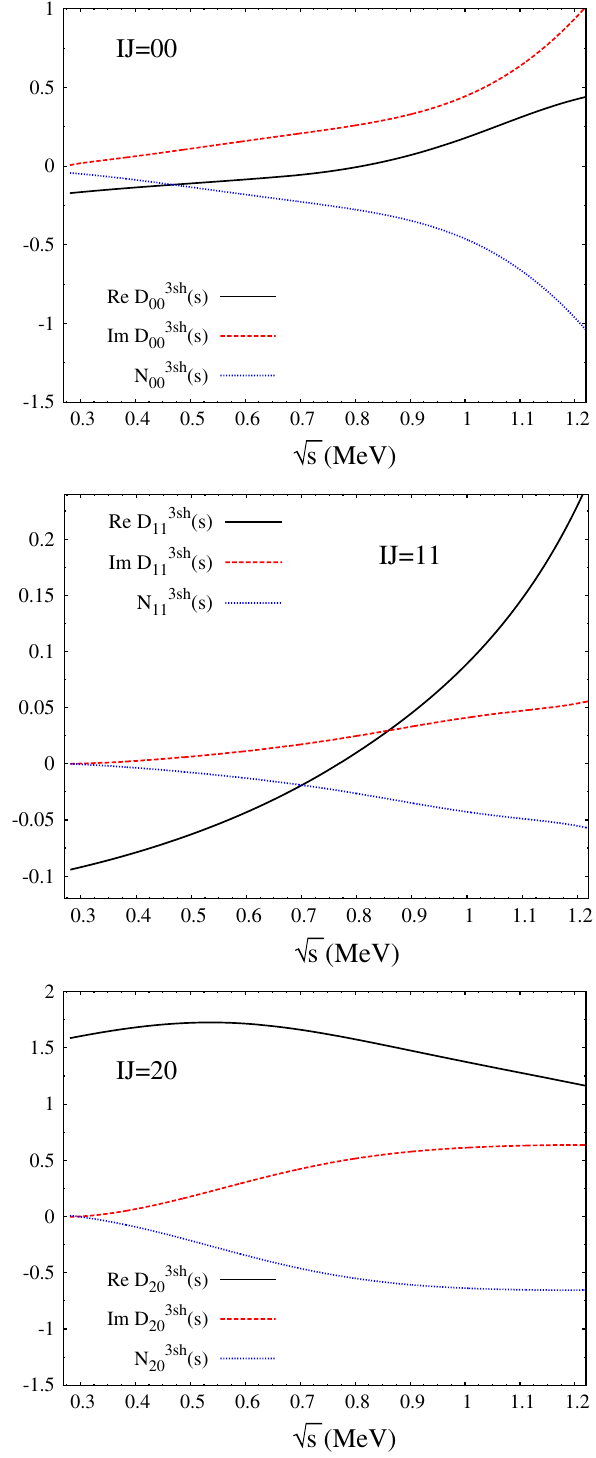
Fig. 8 N JI and D JI (dimensionless) functions appearing in the N/D method (see main text) as a function of the CM energy for I = 0 (top), I = 1 (middle) and I = 2